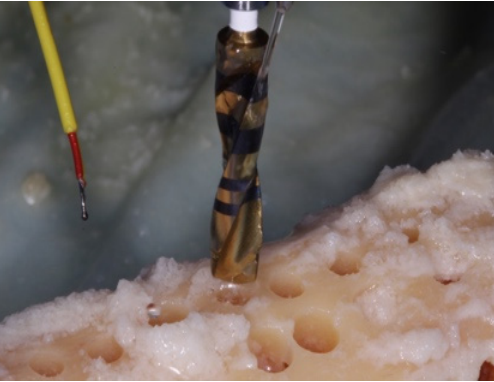
Figure 7. Each osteotomy was completed starting with the pilot drill and with external irrigation at each of the 800, 1000, or 1200 RPM drilling speeds ( Step 2 ).